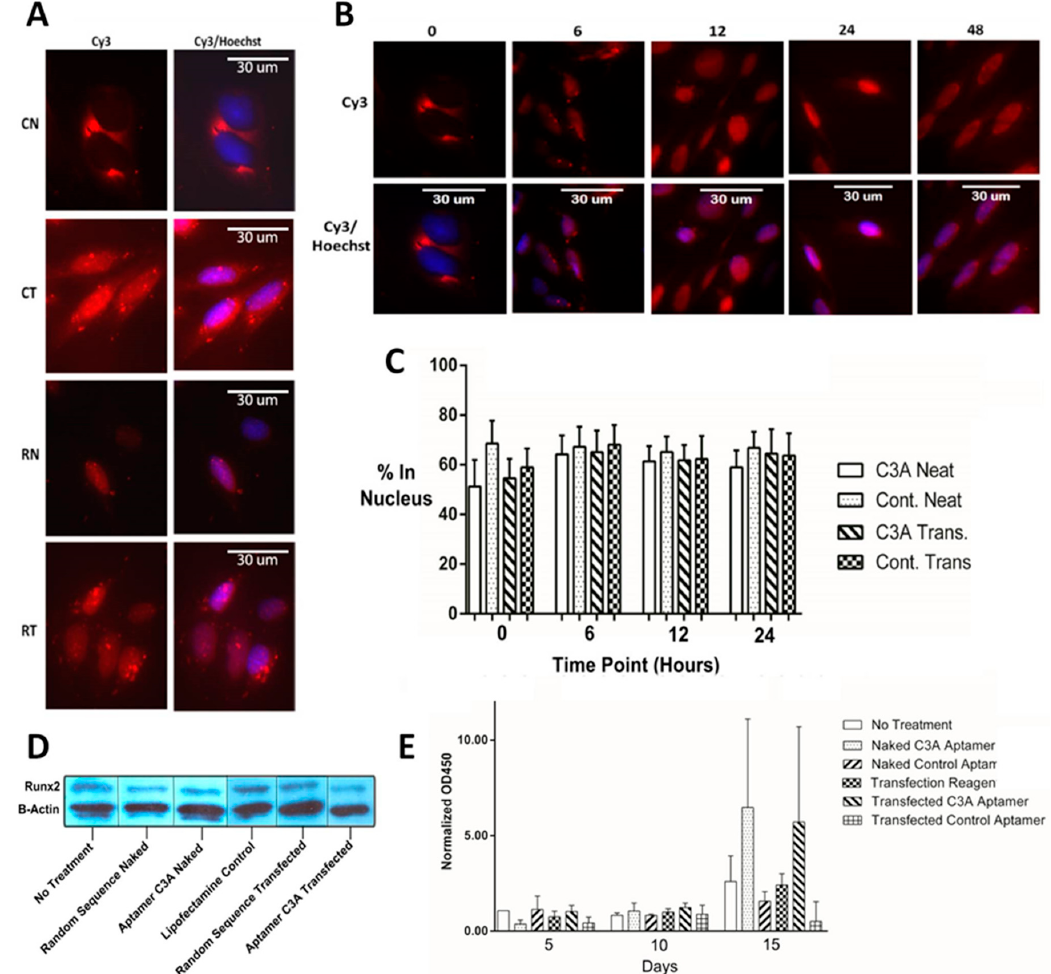
Figure 5. Aptamer C3A localization, and effect on Runx2 levels and bone mineralization in SaOS-2 cells. ( A ) Aptamer (Cy3) nucleus (Hoechst) overlays where: RN—random sequence control without transfection, RT—random sequence control with transfection, CN—aptamer C3A without transfection, and CT—aptamer C3A with transfection; ( B ) Aptamer and nucleus overlays over time points in hours; ( C ) Quantitative assessment of nuclear localization using MetaMorph™ software for transfected or naked (labeled as “NEAT”) aptamer C3A and random sequence control; ( D ) Western Blot of Runx2 performed on SaOS-2 cell extracts; ( E ) Quantitation of extracellular matrix deposition over time using Alizarin Red